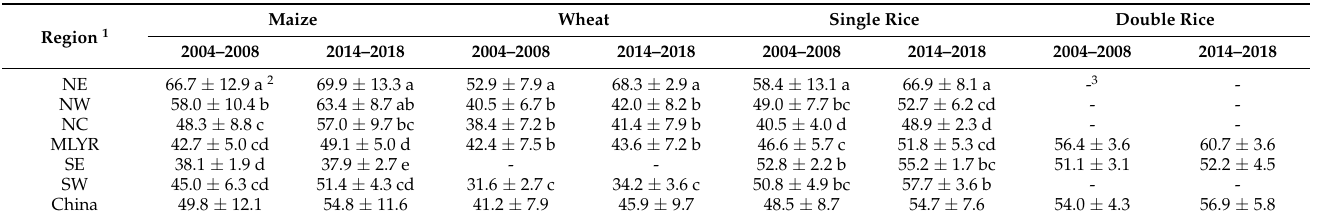
Figure 4. Nitrogen use efficiency (%) for maize, wheat, single rice and double rice from 2004 to 2018 in China farmlands, respectively. Table 2. Nitrogen use efficiency (NUE, %) for maize, wheat, single rice and double rice between the 2004–2008 and 2014–2018 at the region and national scale in China’s farmlands,